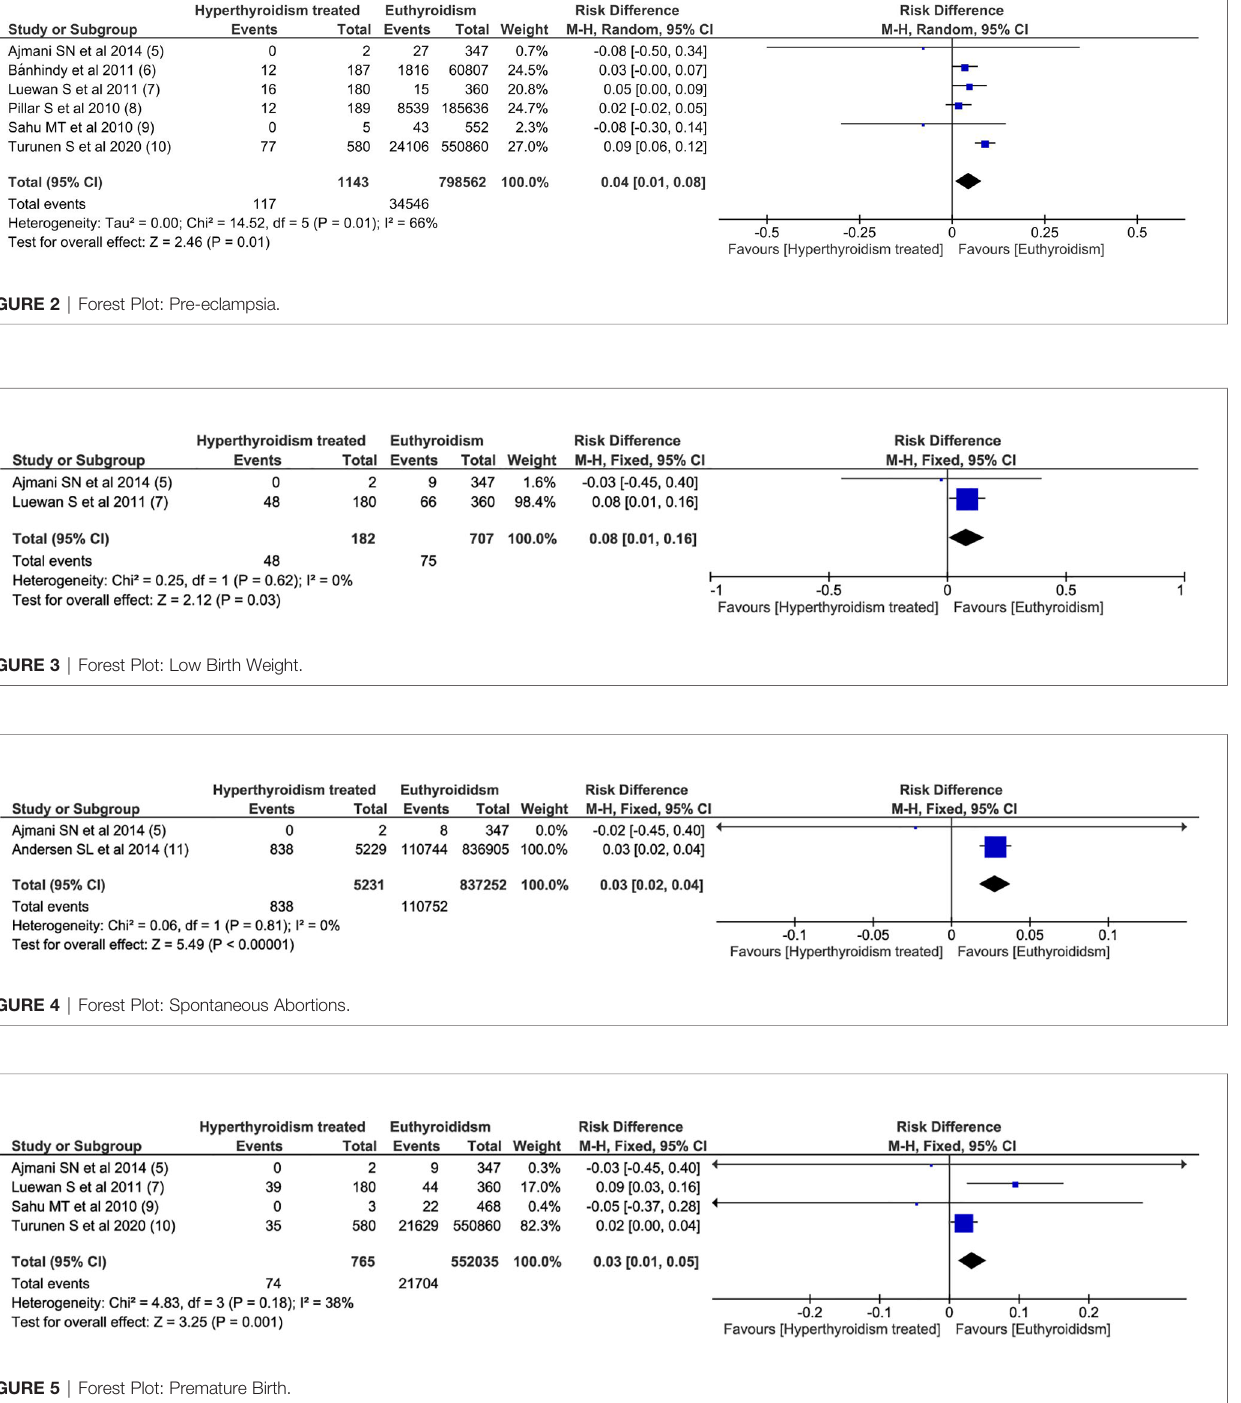
weight, spontaneous abortion, and premature birth) in comparison to euthyroid women. The differences were slight, rst-trimester spontaneous abortion and during the second and